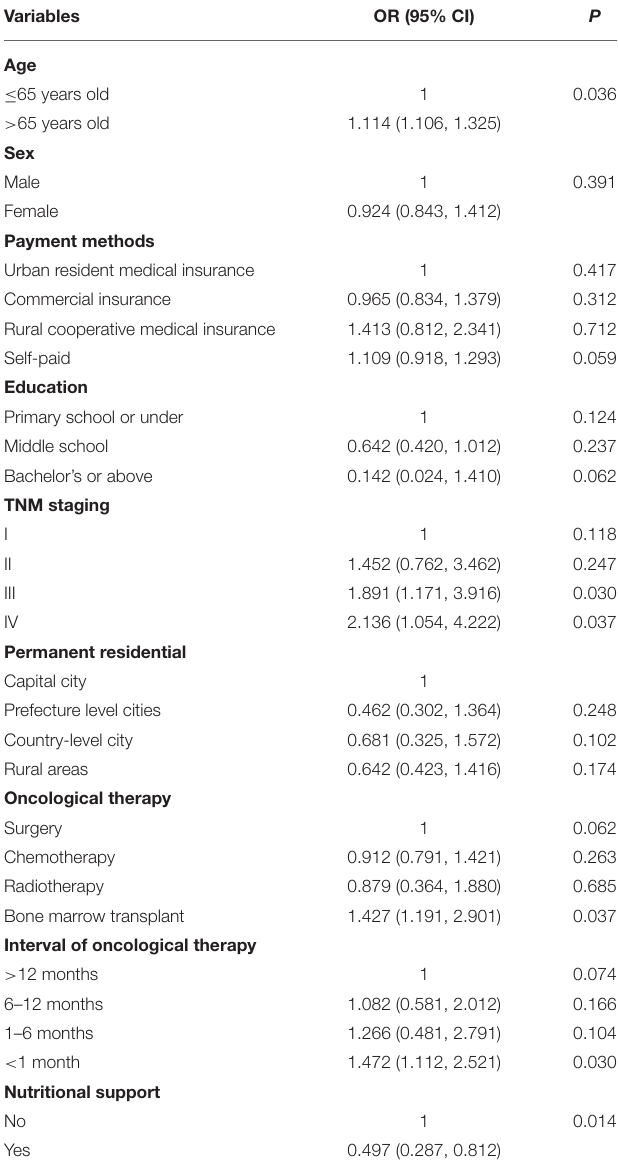
TABLE 3 | The regression analysis of influencing factors and nutritional